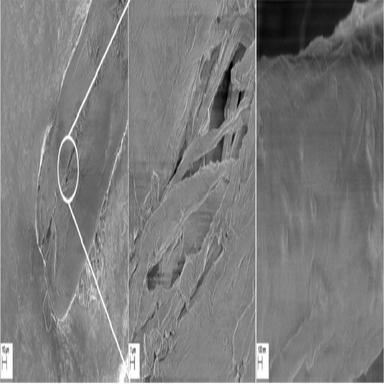
SEM images of MP debris from low to high magnification (form left to right).